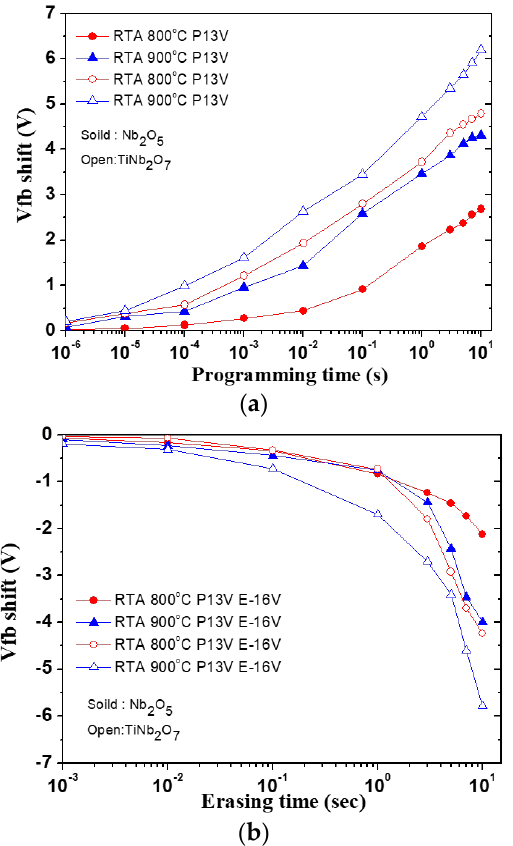
Figure 3. ( a ) Programming and ( b ) erasing speed of the Nb 2 O 5 and TiNb 2 O 7 charge trapping nano-layers for 800 and 900 °C annealing under Vg = 13 V programming voltage and −16 V erasing voltage.